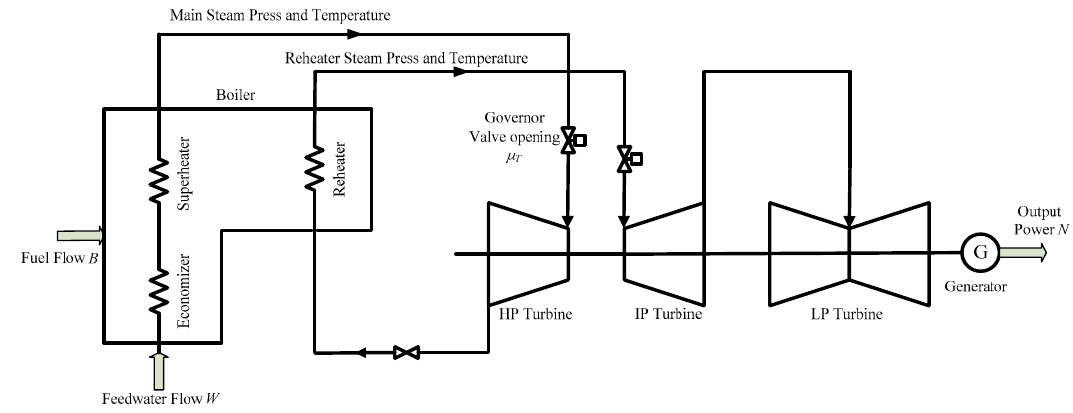
Figure 1. Schematic diagram for an ultra ‐ super ‐ critical (USC) power plant.